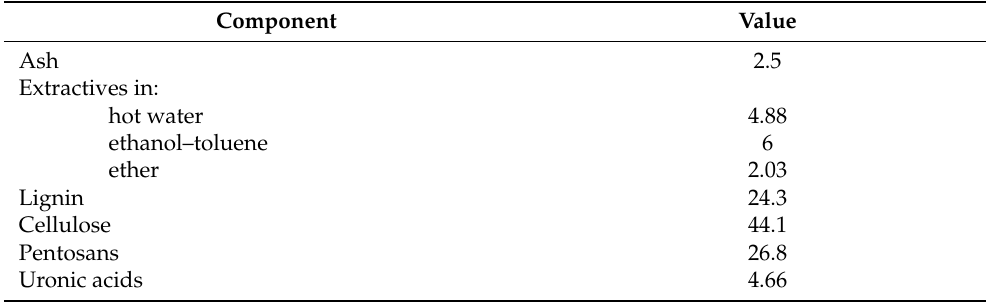
Table 1. Chemical composition of Algerian Alfa plant (fraction size: 0.25 − 0.5 mm) (adapted from [20]).